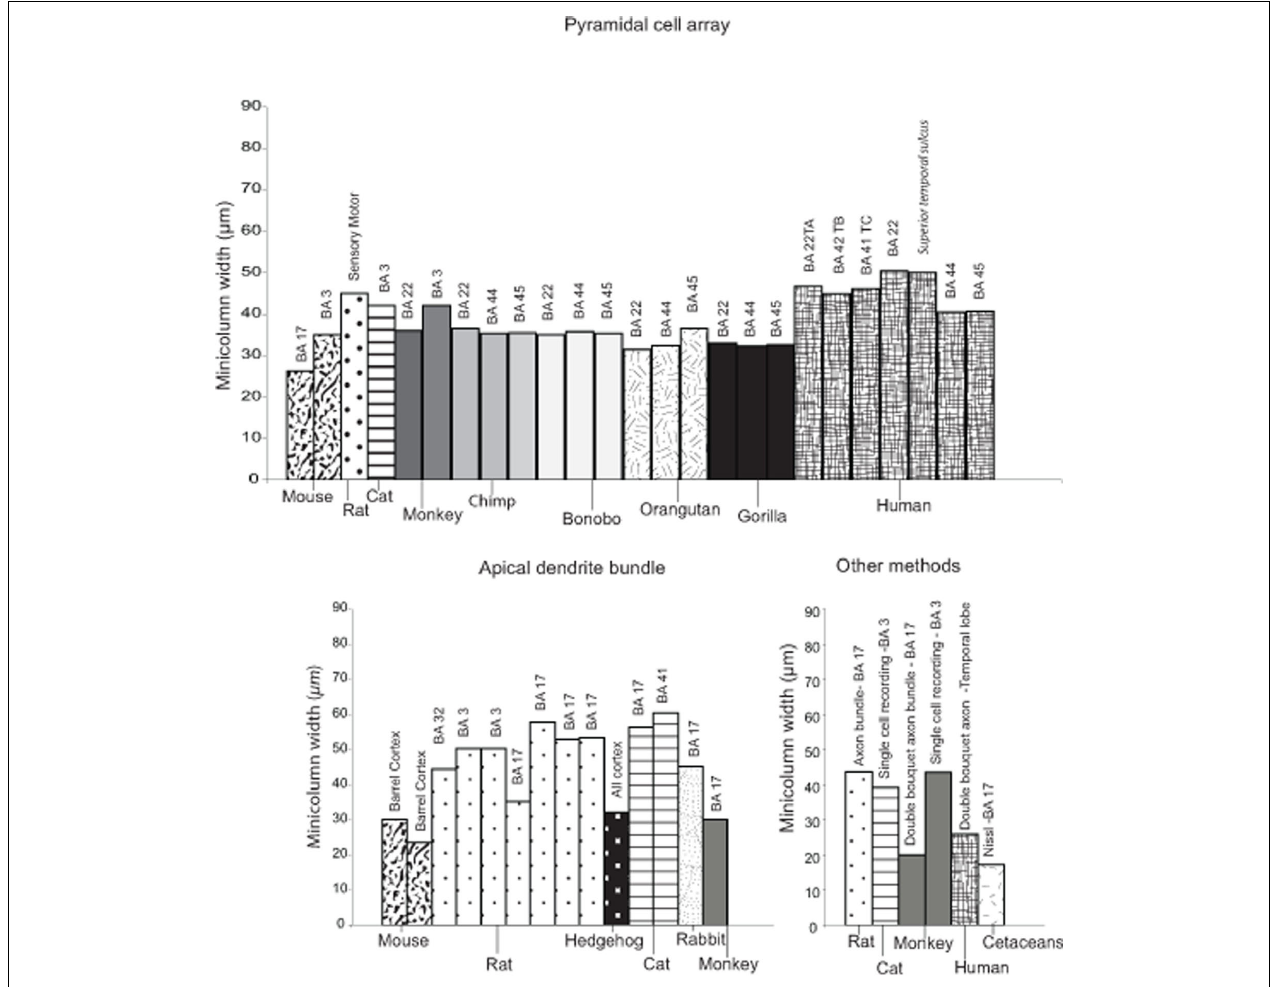
FIGURE 1 | Minicolumn widths collated from the literature for the Class Mammalia. The following sources were used: Escobar et al. (1986), White and Peters (1993), Peters and Yilmaz (1993), Feldman and Peters (1974), Favorov and Diamond (1990), Tommerdahl et al. (1993), Gabbott and Bacon (1996), Peters and Walsh (1972), Peters and Kara (1987), Kohn et al. (1997), Fleischauer et al. (1972), DeFelipe et al. (1990), Peters and Sethares (1991), Peters and Sethares